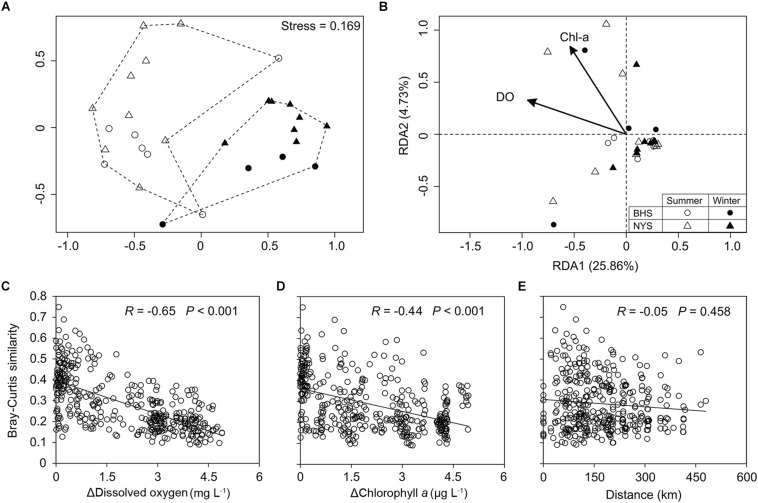
Variations in taxonomic community composition of pico-/nanoeukaryotes. (A) A non-metric multidimensional scaling plot depicting the distinct seasonality of taxonomic community structure in NYS and BHS. (B) Plot of redundancy analysis (RDA) showing dissolved oxygen and chlorophyll a significantly (Monte Carlo test, P < 0.05) co-varied with the taxonomic community composition. (C–E) Scatter plots showing that the similarity in taxonomic community composition was significantly decreased with the differences in dissolved oxygen (C) and chlorophyll a
(D), but not with that of geographic distance between samples (D).